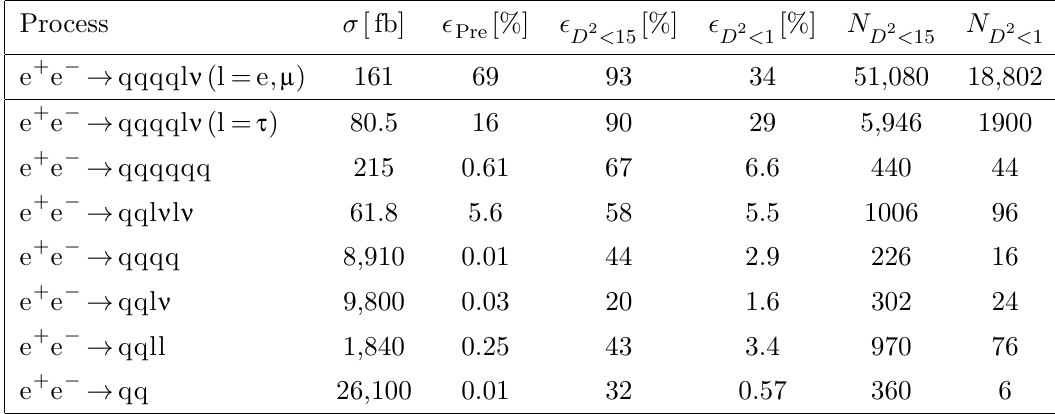
Table 7. Pre-selection and (cid:12)nal event selection e(cid:14)ciencies and expected number of events for the tt analysis of CLIC at a nominal collision energy of 380 GeV. The numbers are shown for P(e (cid:0) ) = -80% assuming 0 : 5 ab (cid:0) 1 .